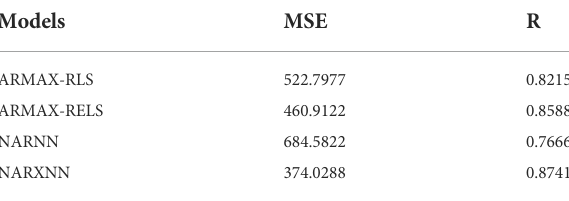
TABLE 4 Comparison of the Prediction Performance on Energy Consumption over four steps ahead.